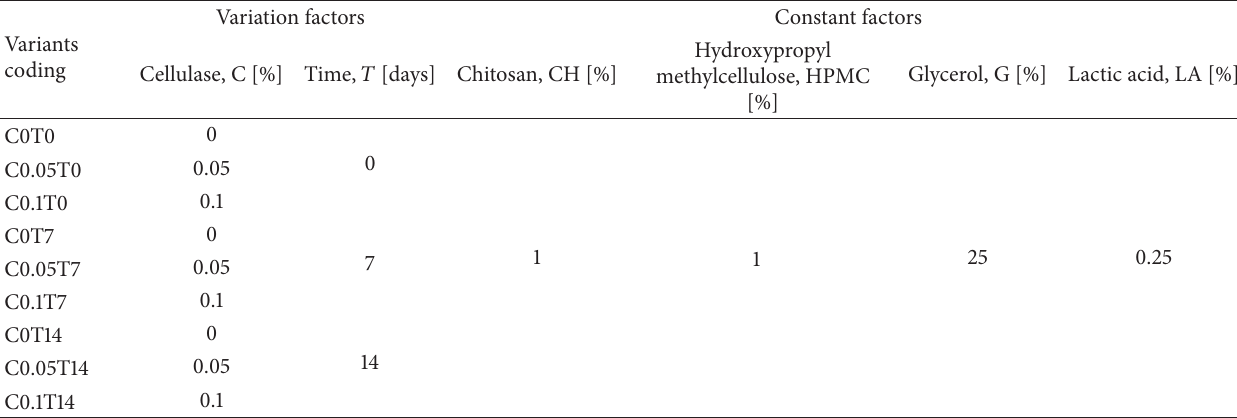
Table 1: Experimental